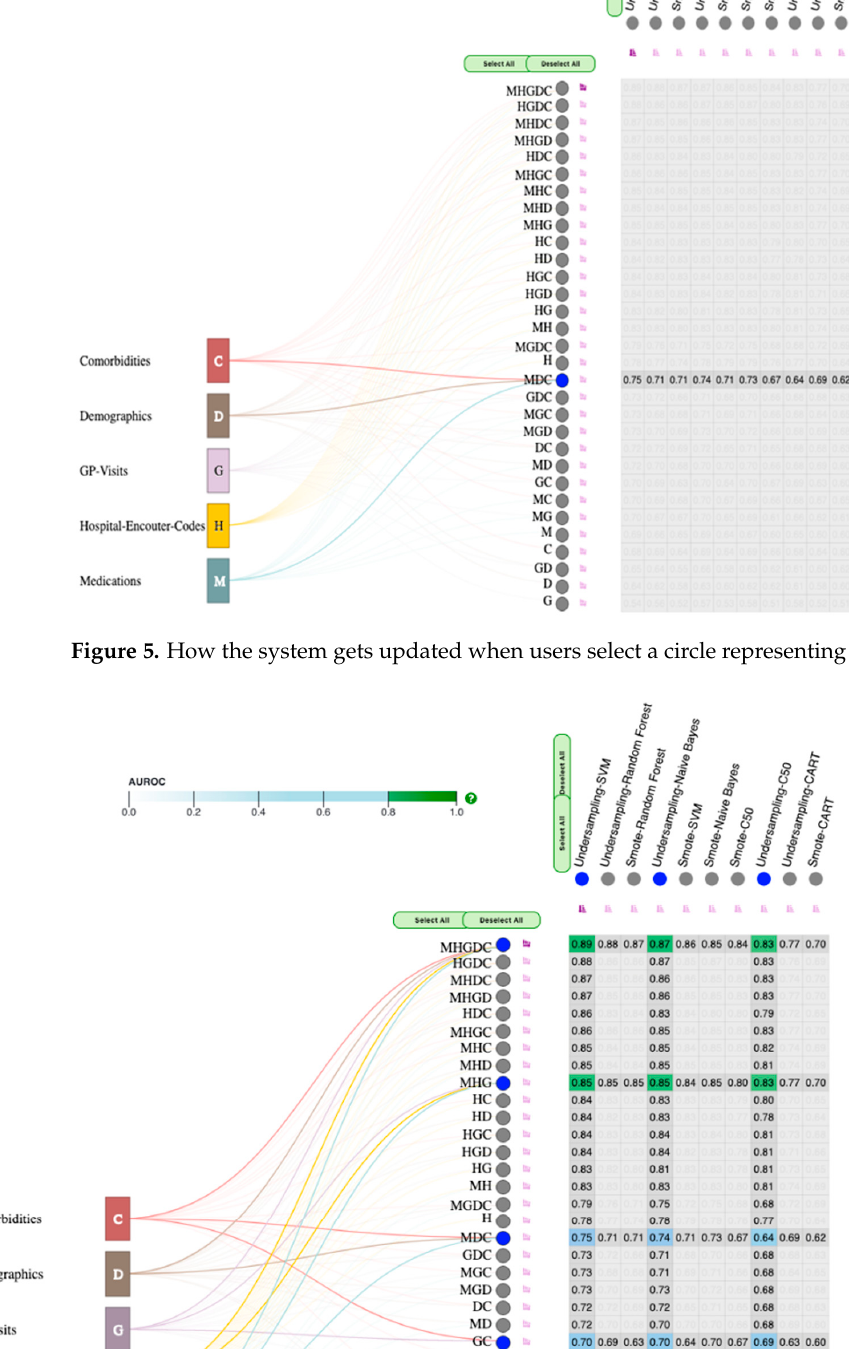
Figure 6. How the system gets updated when users select multiple subset nodes and techniques. The horizontal and vertical groups of “Select All” and “Deselect All” buttons on the top left corner of the heatmap allow users to select/deselect all the subsets and techniques. These buttons help users easily get an overview of all the performances without selecting all the circles individually. VERONICA provides users with a search bar and four drop- down menus on the top left corner of the screen. Suppose users are interested in learning about a specific subset. In that case, they can enter the combination code corresponding to that subset in the search bar to change its color from black to green in the interface. In addition, when users hover their mouse over the help button placed beside the search bar, a tooltip appears with information on how to use the search bar.